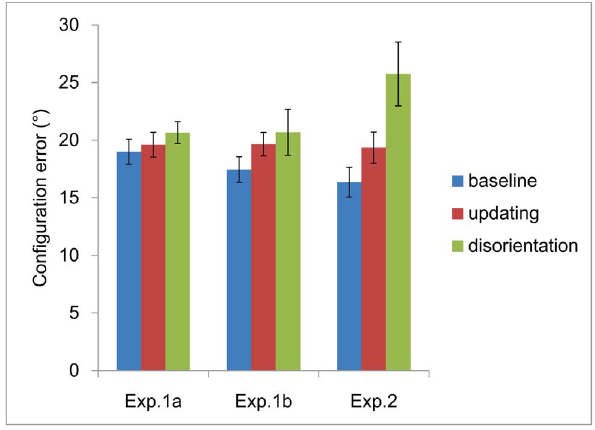
Figure 2. Configuration errors in Experiment 1a, Experiment 1b, Experiment 2, as a function of rotation condition and instruction. Error bars are confidence intervals corresponding to 6 1